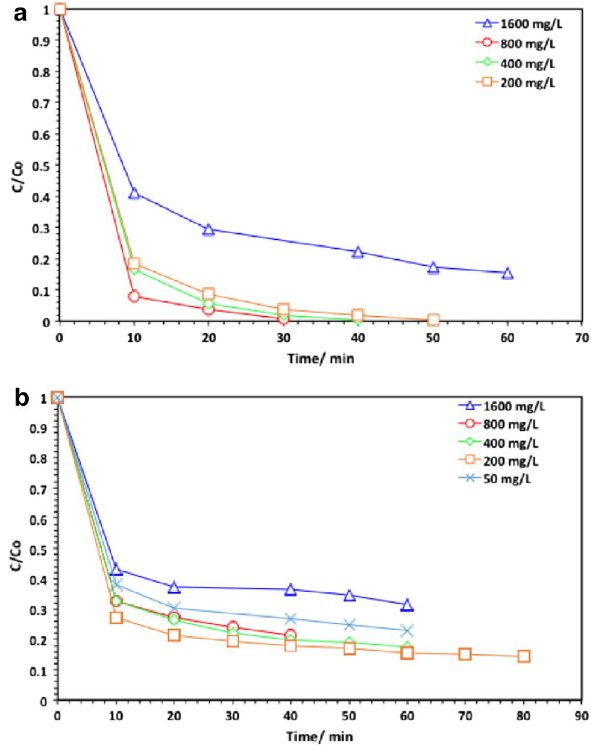
Fig. 5 Effect of different hydrogen peroxide doses on a LFR (Dye 100 mg/L; AS400 1 g/L; pH 3.0) and b LA (Dye o 50 mg/L; AS400 1 g/L; pH 3.0) azo-dyes removal during oxidation for different